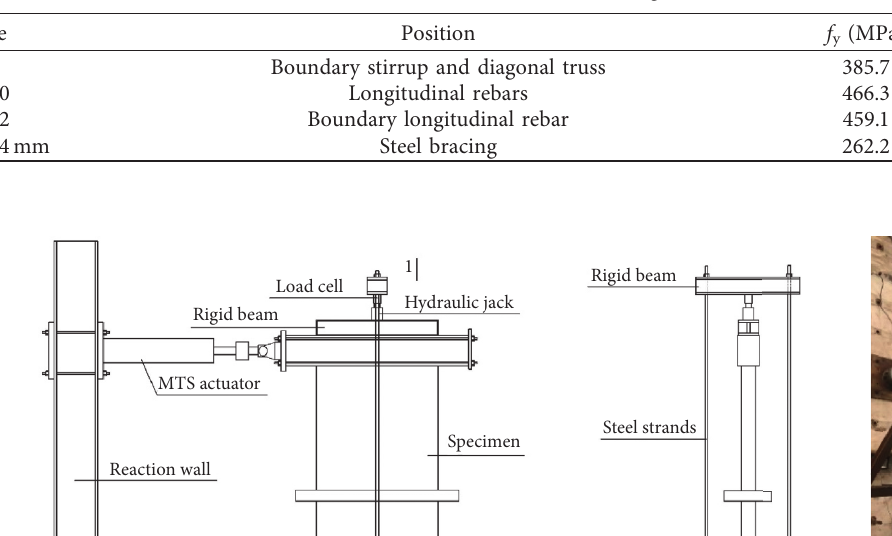
Table 2: Measured strength of